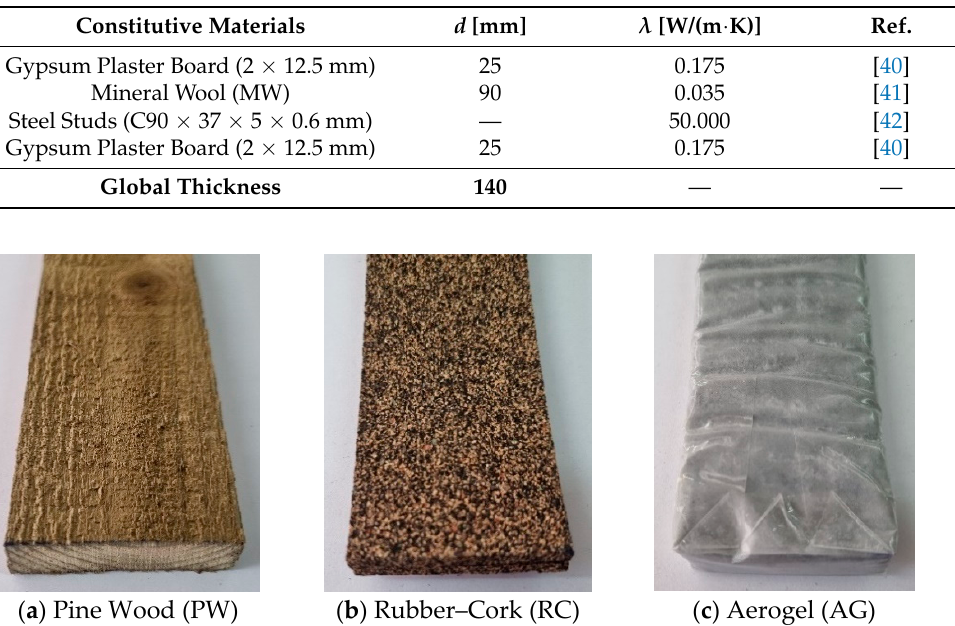
Figure 1. Materials, dimensions, and geometry of the reference LSF partition cross-section. Table 1. Thicknesses ( d ) and thermal conductivities ( λ ) of materials used in the reference LSF partition wall.